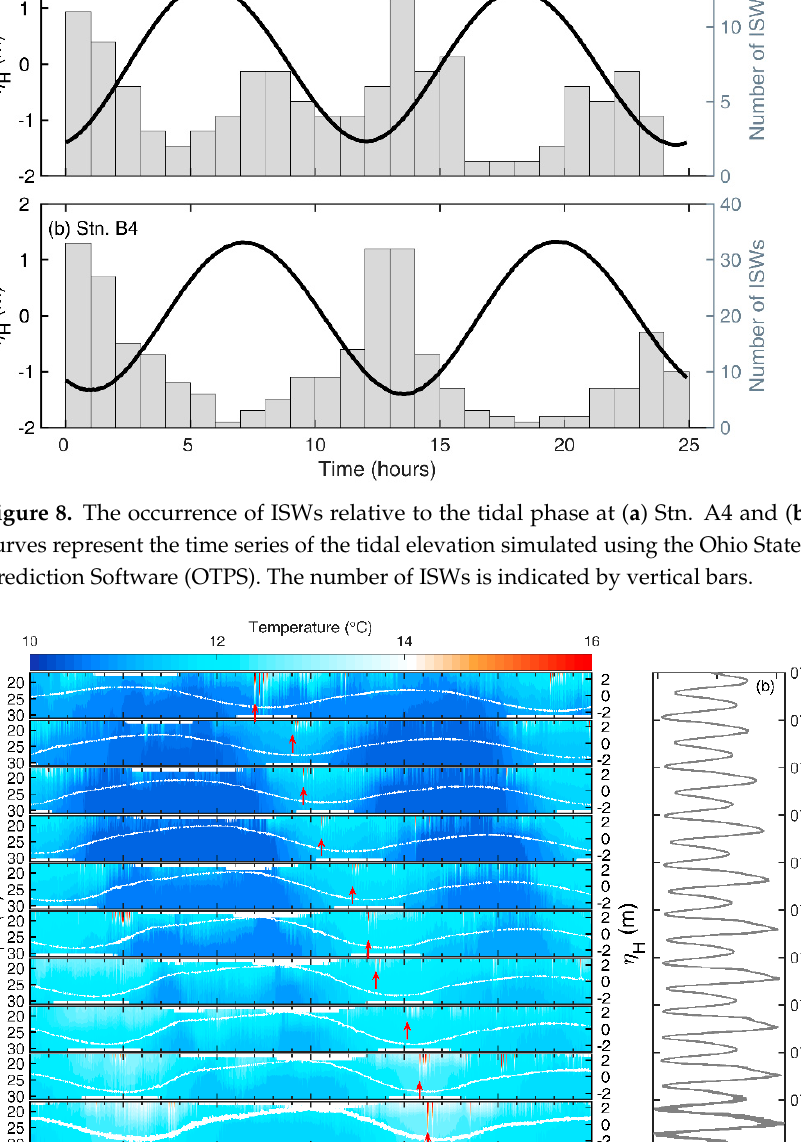
Figure 8. The occurrence of ISWs relative to the tidal phase at ( a ) Stn. A4 and ( b ) Stn. B4. Black curves represent the time series of the tidal elevation simulated using the Ohio State University Tidal Prediction Software (OTPS). The number of ISWs is indicated by vertical bars.